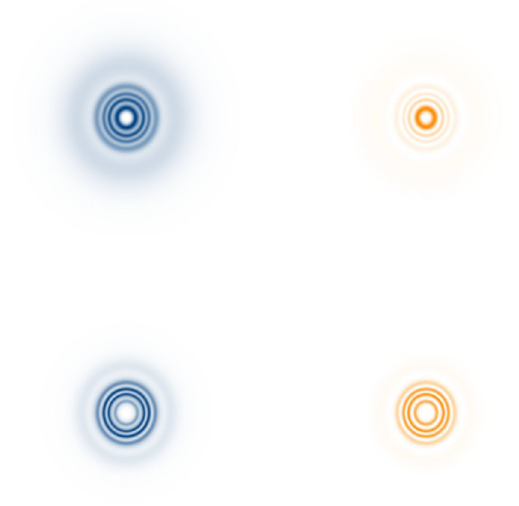
Fig. 13 The electric field (left, blue) with e = 1 and the energy density (right, orange) associated to the model in Sect. 4.1.2 depicted in the plane for σ = 5, α = 2 and n = 2, with k = 1 (top) and 2 (bottom). The intensityof the blue and orange colors increases withthe increasing of the electric field and energy density,